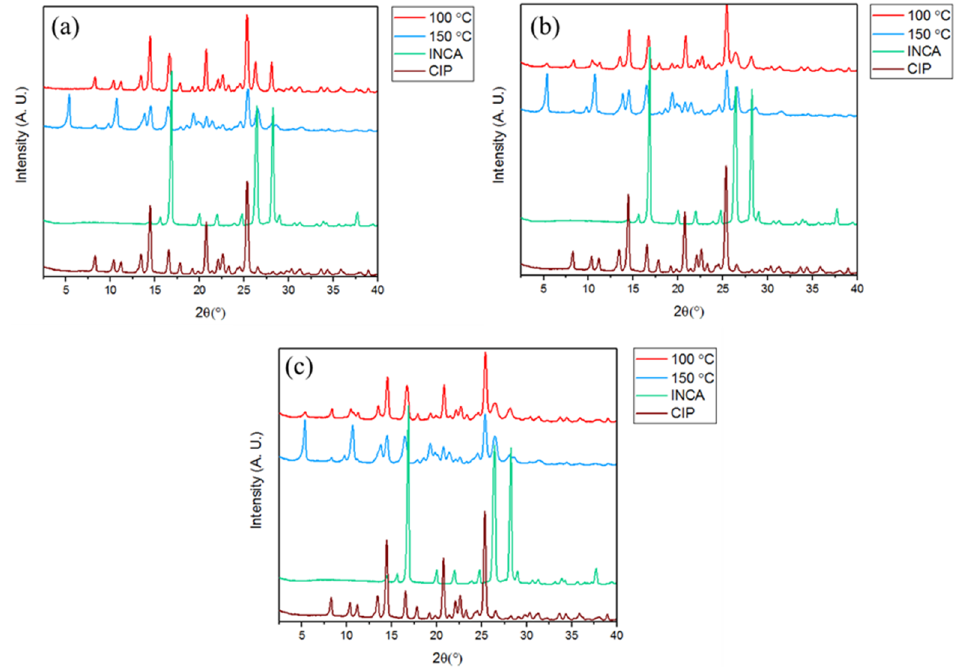
Figure A1. PXRD spectra of samples extruded at various temperature using kneading screw configu- ration at screw speeds of ( a ) 10 rpm, ( b ) 55 rpm, and ( c ) 100 rpm.